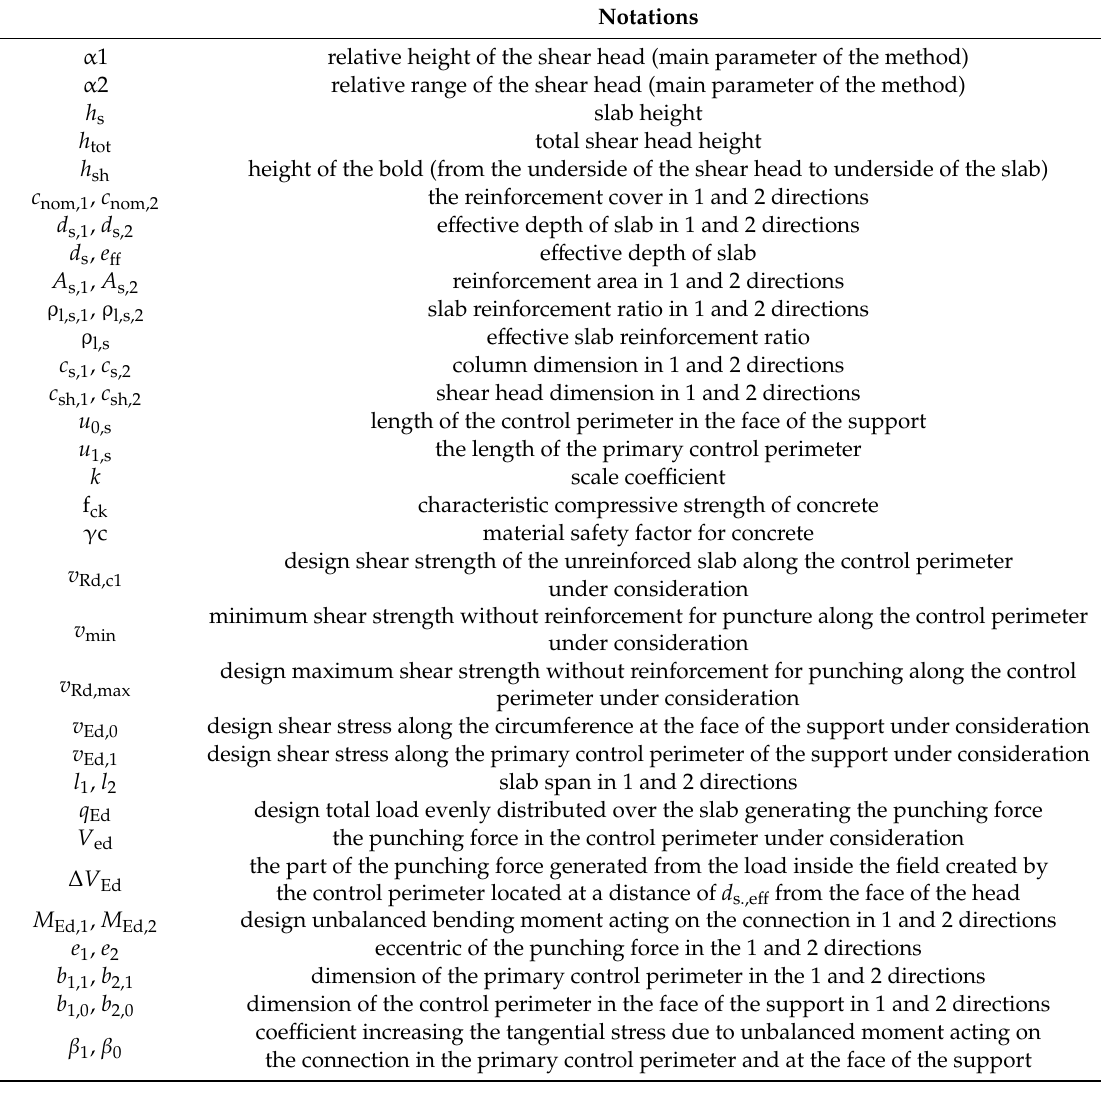
Table A1. Notations used in Appendix